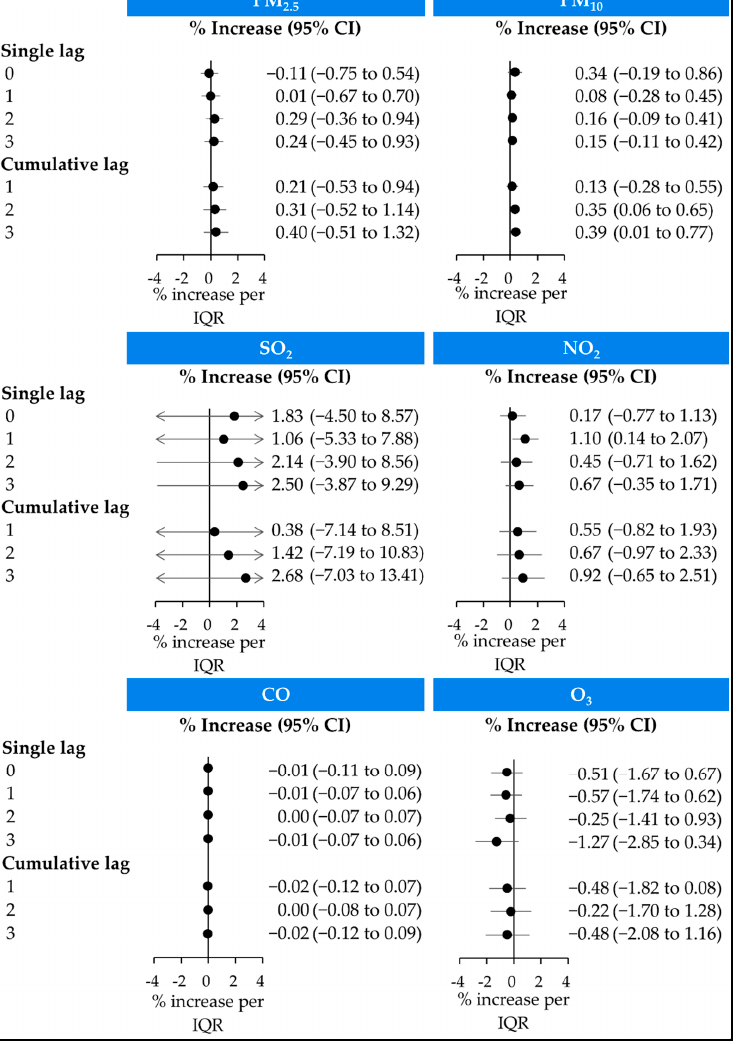
Figure 1. Random-effects estimate of the risk of acute exacerbation of chronic obstructive pulmonary disease associated with an interquartile range (IQR) increase in pollutant concentrations in seven metropolitan cities in South Korea, 2015. The day of outcomes, and 1, 2, and 3 days prior to the day of the hospital visit, were described as lag 0, lag 1, lag 2, and lag 3, respectively. Cumulative lag refers to cumulative lagged exposure, which indicates the mean particulate matter concentrations on a specific day and all subsequent days. After adjusting for national holidays and natural cubic spline variables (mean temperature, dew point temperature, and air pressure), the IQRs were as follows: PM 2.5 ,17.46 μ g/m 3 ; PM 10 , 25.50 μ g/m 3 ; SO 2 , 3.04 ppb; NO 2 , 13.57 ppb; CO, 206.82 ppb; O 3 , 15.37 ppb. PM 2.5 , fine particulate matter with a median aerodynamic diameter of ≤ 2.5 μ m; PM 10 , fine particulate matter with a median aerodynamic diameter of ≤ 10 μ m; SO 2 , sulfur dioxide; NO 2 , nitrogen dioxide; CO, carbon monoxide; O 3 , ozone; CI, confidence interval. The arrow at the end of the line means that the CI extends over the range of x -axis.